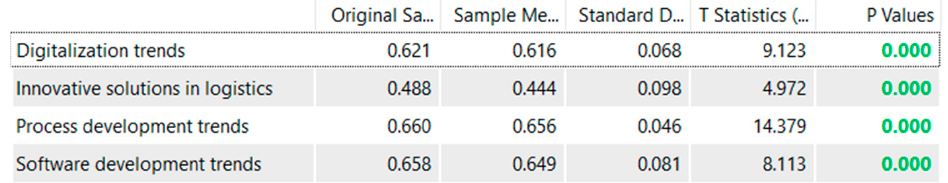
Figure 2. Quality criteria: AVE of the model.